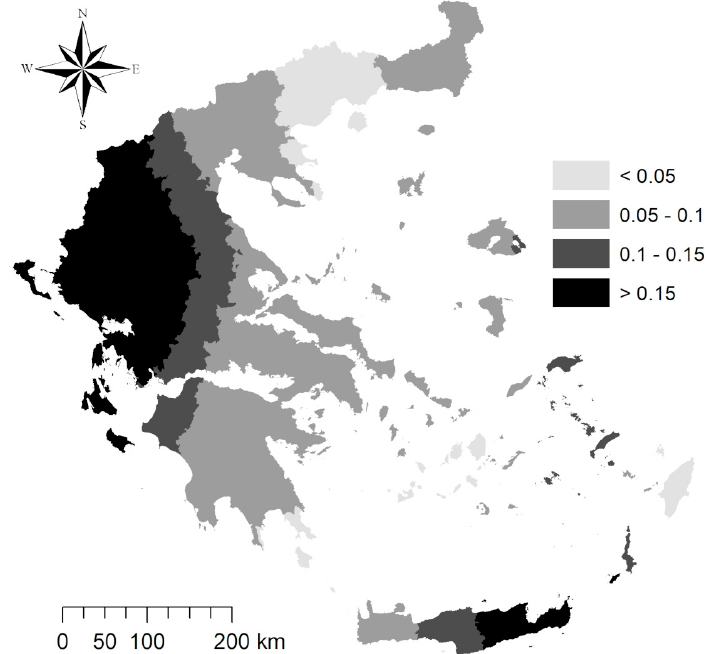
Figure 9. Absolute change in the GWR regression coefficient (local slope) during two consecutive decades in Greece, 1981–2001.